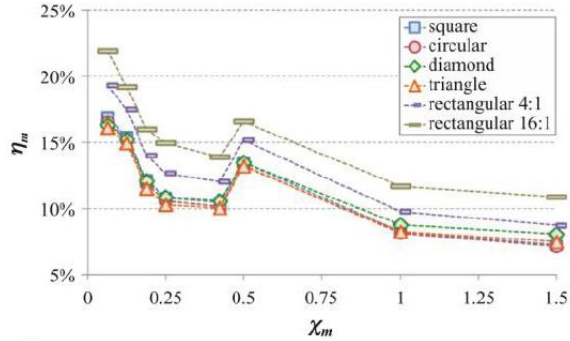
Figure 6. Mixing efficiency study for varied injector geometries [6] (graph of mixing efficiency η m vs. Downstream Location X m ).